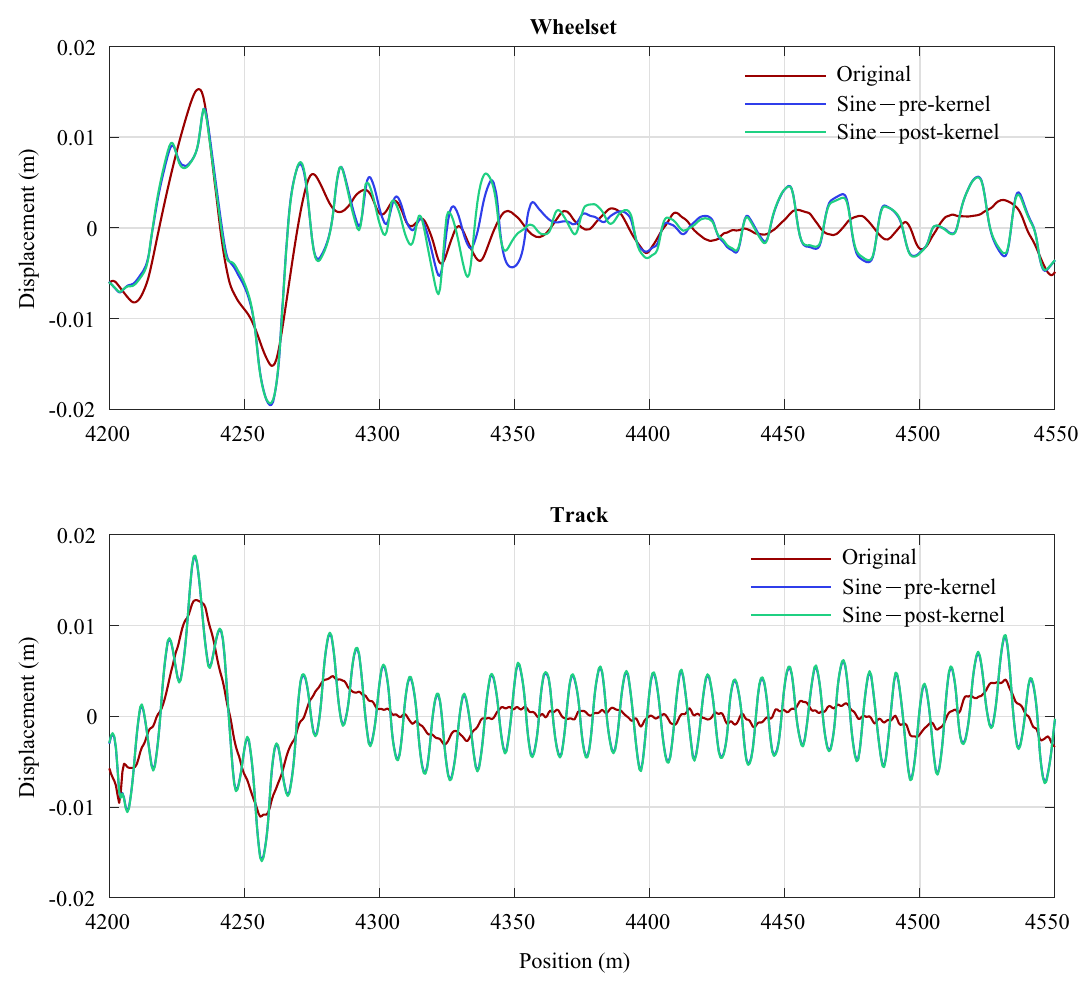
Fig. 8 Simulation with gauge variations with 5 mm amplitude and 10 m wavelength. Pre-kernel indicates that the sine wave is added to the track measurements before using the kernel and similarly post-kernel implies that the sine wave is added to the track measurements after using the kernel. The latter ensures that the sine wave is unaffected by the kernel. The blue curve in the track data lies under the green